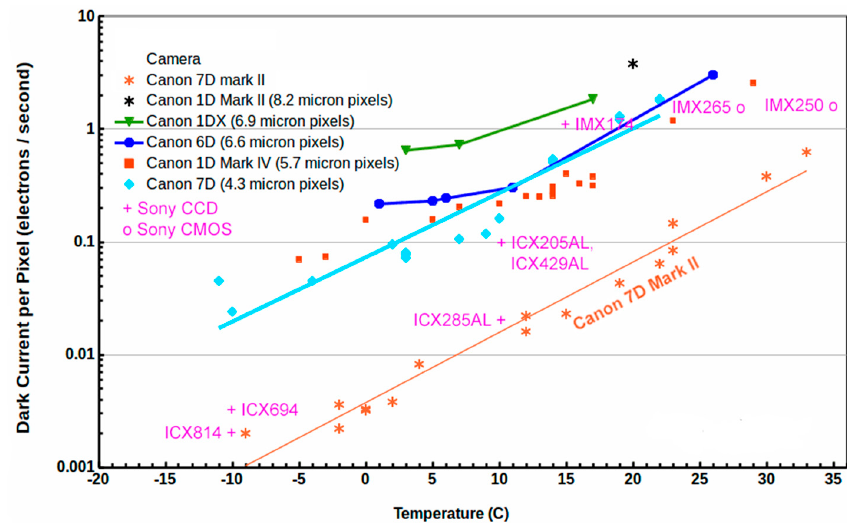
Figure 12. Sony CMOS dark current comparison with counterparts.